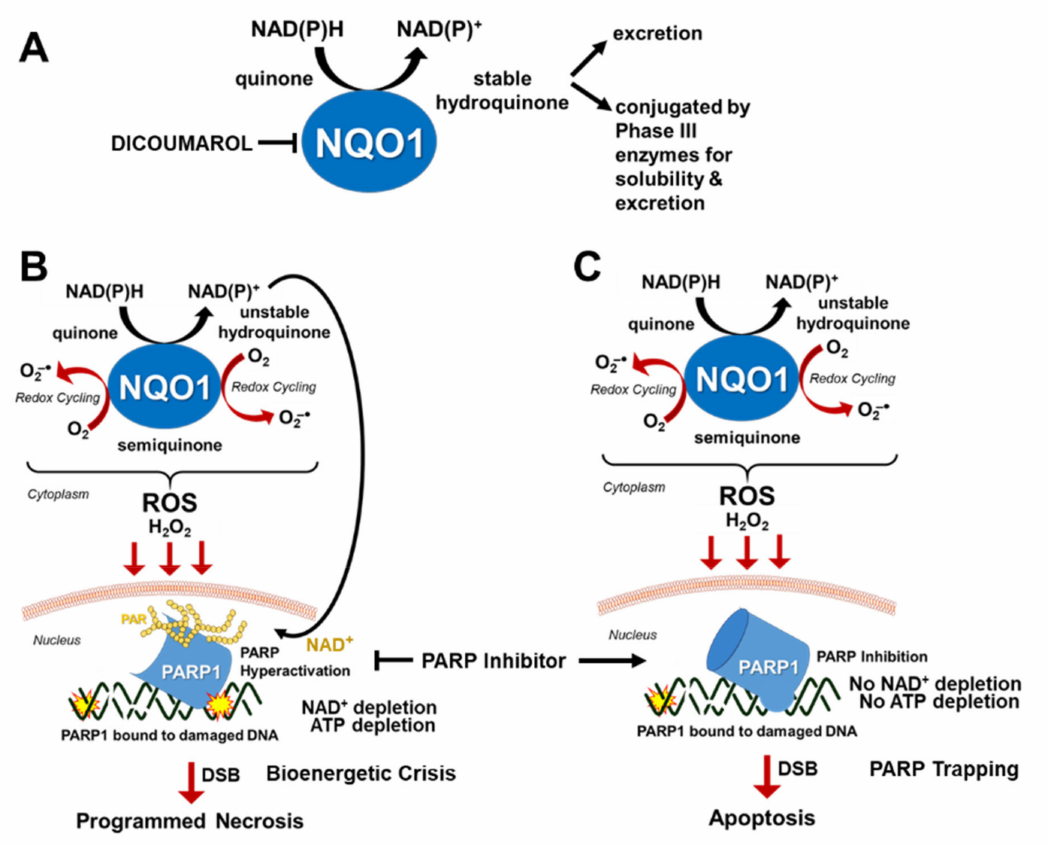
Figure 3. Strategy for tumor-selective use of PARP inhibitors in solid tumors. ( A ) The role of NQO1 in detoxifying certain quinones for cellular e ffl ux. ( B ) The role of NQO1 in bioactivating certain quinones to induce toxicity in NQO1( + ) cancer cells. Note that the stability of hydroquinones determine whether bioreduction by NQO1 leads to detoxification or toxicity. ( C ) Mechanism of tumor-selective synergistic cell death induced by combination of PARP inhibitor and NQO1-bioactivatable agents in NQO1( + )